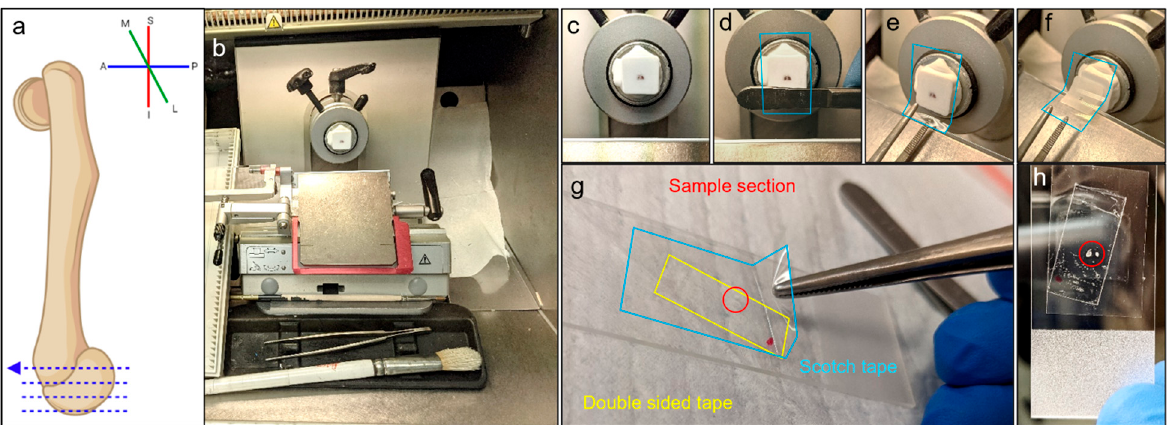
Figure 1. The cryosectioning process for non-decalcified murine distal femurs. ( a ) Graphic showing the orientation of the femurs during sectioning. Sections are in the lateral plane starting at the most distal part of the femur. ( b ) An image of the sectioning station at the cryostat, including mounted block, slide box, brush, and tweezers. ( c – f ) Process of tape transfer. The block is secured on the cryostat ( c ), and double-sided Scotch tape is smoothed onto the cut surface of the block with a tweezer handle ( d ). The tape is held with the tweezers, while the blade is advanced toward the block ( e ). The tape is pulled away with cut section on sticky side ( f ). ( g ) The tape (blue) with the section (red) is smoothed onto the prepared slide with double-sided tape (yellow) and the specimen facing upward away from the slide. ( h ) The section of the distal femur is visible on the slide after cryosec- tioning.